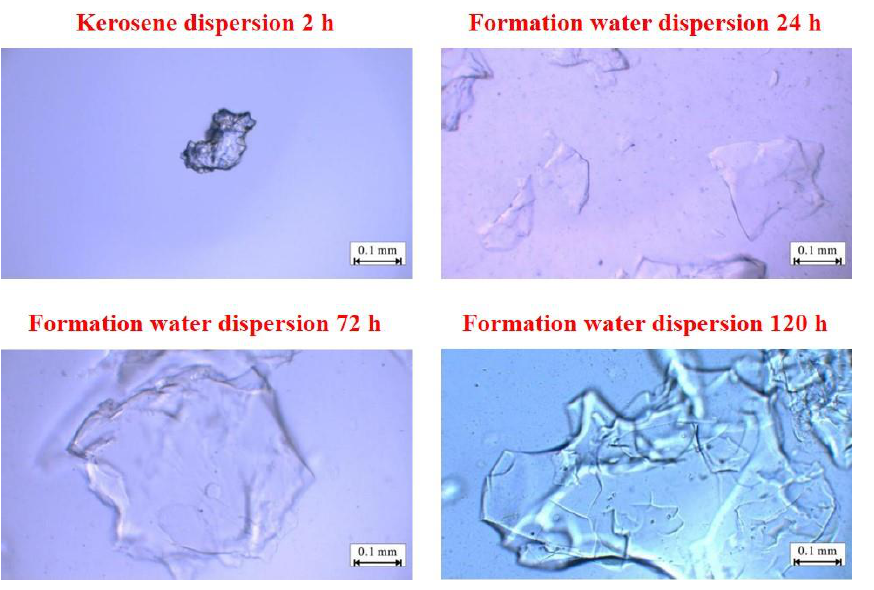
chromium cross-linking agent, the gelation time of the gel was shortened, and the strength